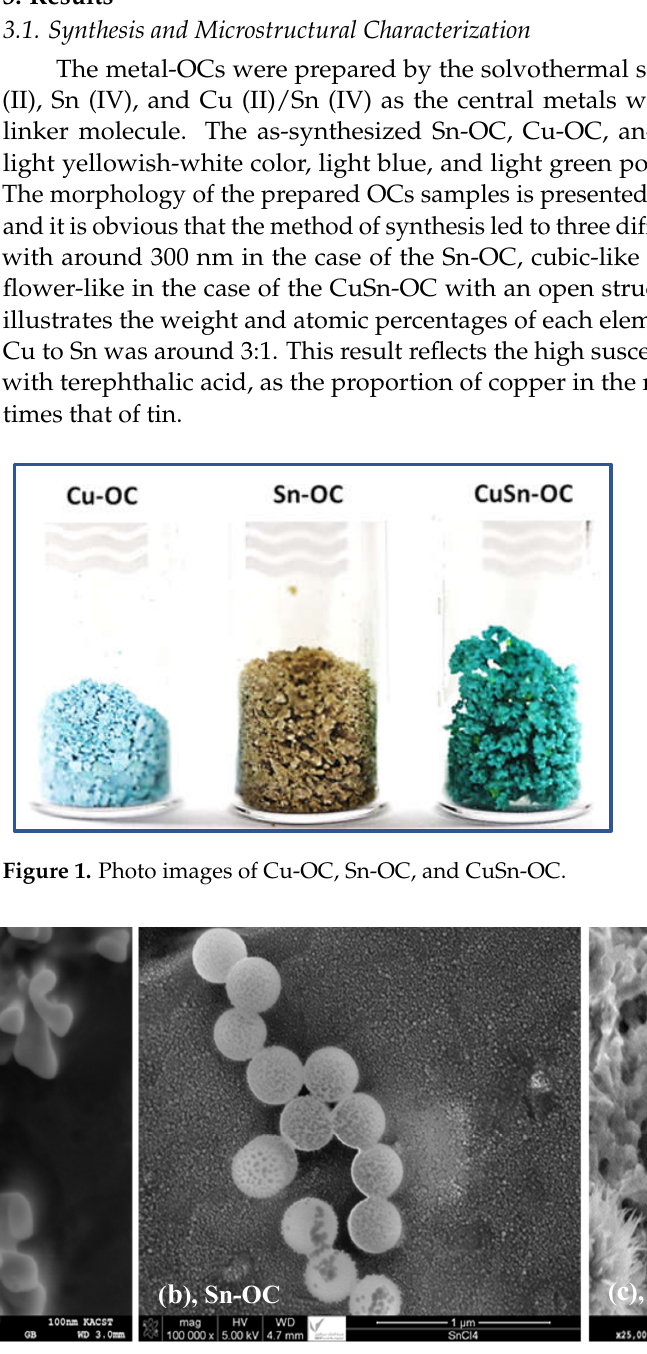
Figure 2. SEM images of as-prepared Sn-OC ( a ), Cu-OC ( b ), and CuSn-OC ( c ). Table 2. EDX element analysis table for CuSn-OC.